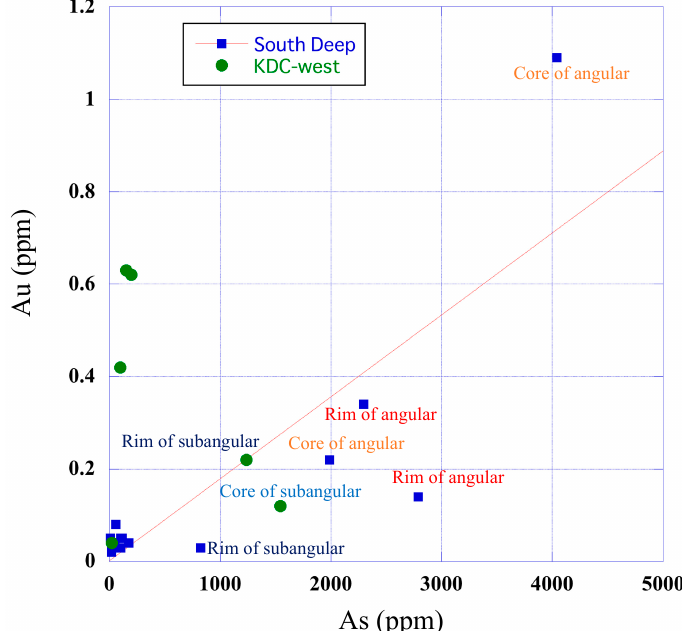
Figure 6. Relationship between Au and As concentrations (ppm) in pyrite from the South Deep and KDC West deposits. A rough positive correlation ( R 2 = 0.71) between the Au and As concentrations was obtained for the South Deep pyrite, whereas the relationship for the KDC West deposit showed different behavior from that of the South Deep deposit. The analysis position (rim or core) and the shape of the pyrite are given near the symbol.